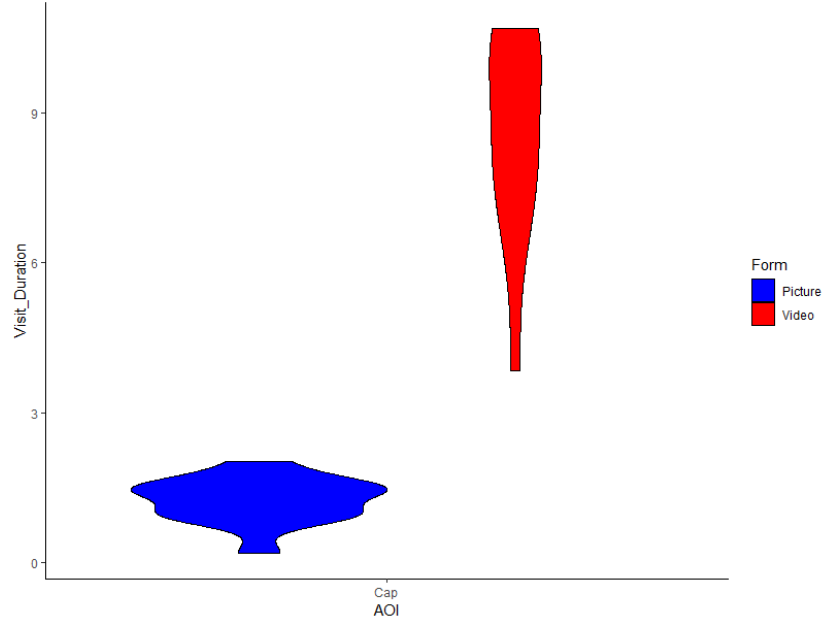
Figure 8. Violin plots highlighting the most significant differences on TVD Diff% between forms of representation for the product OnPot. representation for the product